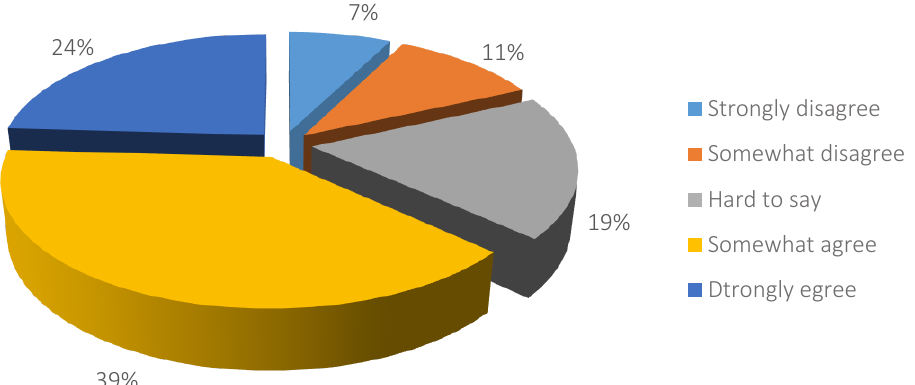
Figure 1. Assessment of the quality of interpersonal relationships at